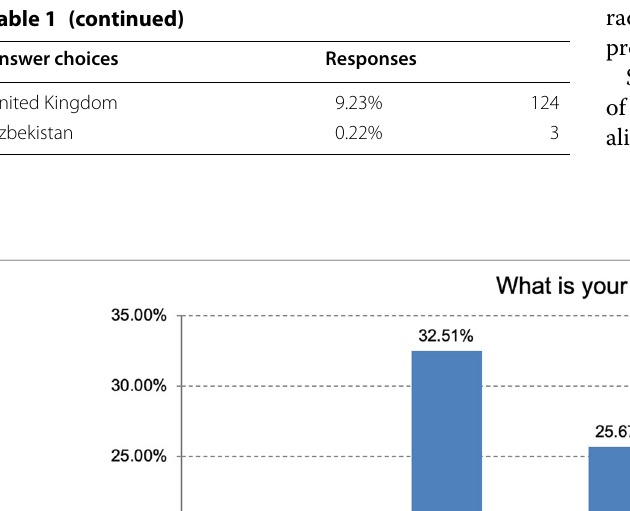
Fig. 1 The age range of respondents (responses n